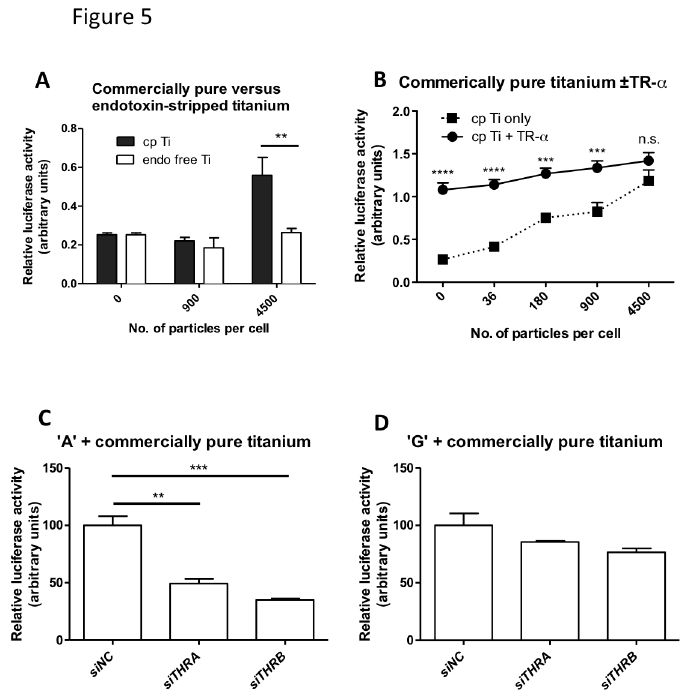
Figure 5. Titanium particles bind LPS and can activate TNF promoter containing the ‘A’, but not the ‘G’ variant of rs361525. Raw 264.7 cells were transiently transfected with the firefly-luciferase reporter under the control of the ‘A’ (panels A-C) or the ‘G’ variant (panel D) of the TNF promoter, and co-transfected with 30ng of TR-α expression plasmid (panel B) or with non- targeting (siNC), THRA or THRB targeting siRNAs, respectively (panels C-D). Transfected cells were stimulated with the stated concentration of Ti particles (panels A-B) or 4500 particles/cell (panels C-D) for 6 hours. Results were analyzed by one-way ANOVA with a Bonferroni post-test. ** p<0.01, *** p<0.001. doi: